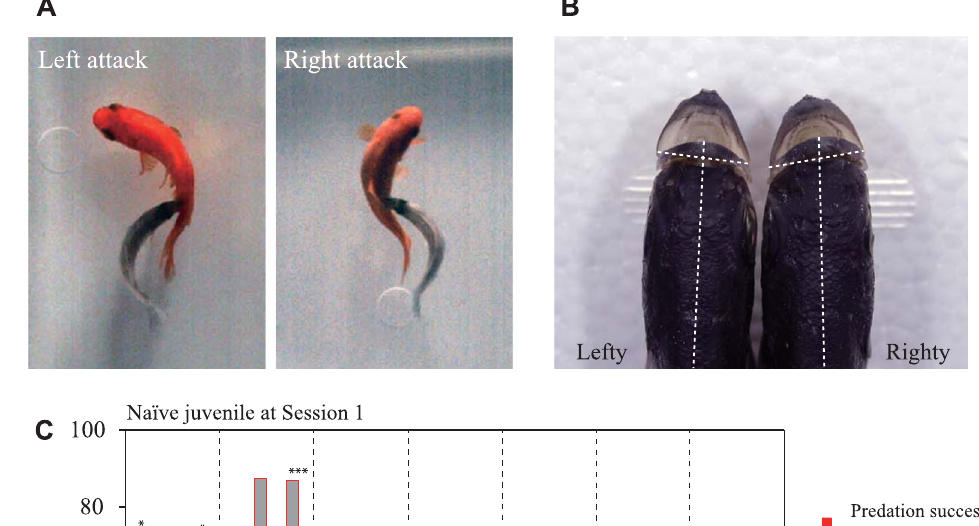
Figure 1. Attack side preference in Perissodus microlepis . ( A ) Photographs of left- and right-sided attacks. ( B ) Dorsal view of the mouth morphologies of lefty and righty fish. The dotted lines indicate the midline and the lateral tips of the lips. Change in the percentage of left-sided (red column) and right-sided (blue column) attacks in each juvenile predator from Session 1 ( C ) (N = 21 fish) to Session 5 ( D ) ( N = 16 fish). Grey columns indicate failed attempts at scale eating. The numbers at the bottoms of the columns indicate the number of attacks by each fish. Asymmetric mouth morphology, lefty (L) or righty (R), is denoted for each fish. P-values are from binomial tests. * P < 0.05; ** P < 0.01; *** P < 0.001. ( E ) Weighted mean ± standard error index of attack side preference at Session 1 for juveniles and wild-caught adults. P-values are from the Wilcoxon rank-sum test. *** P <